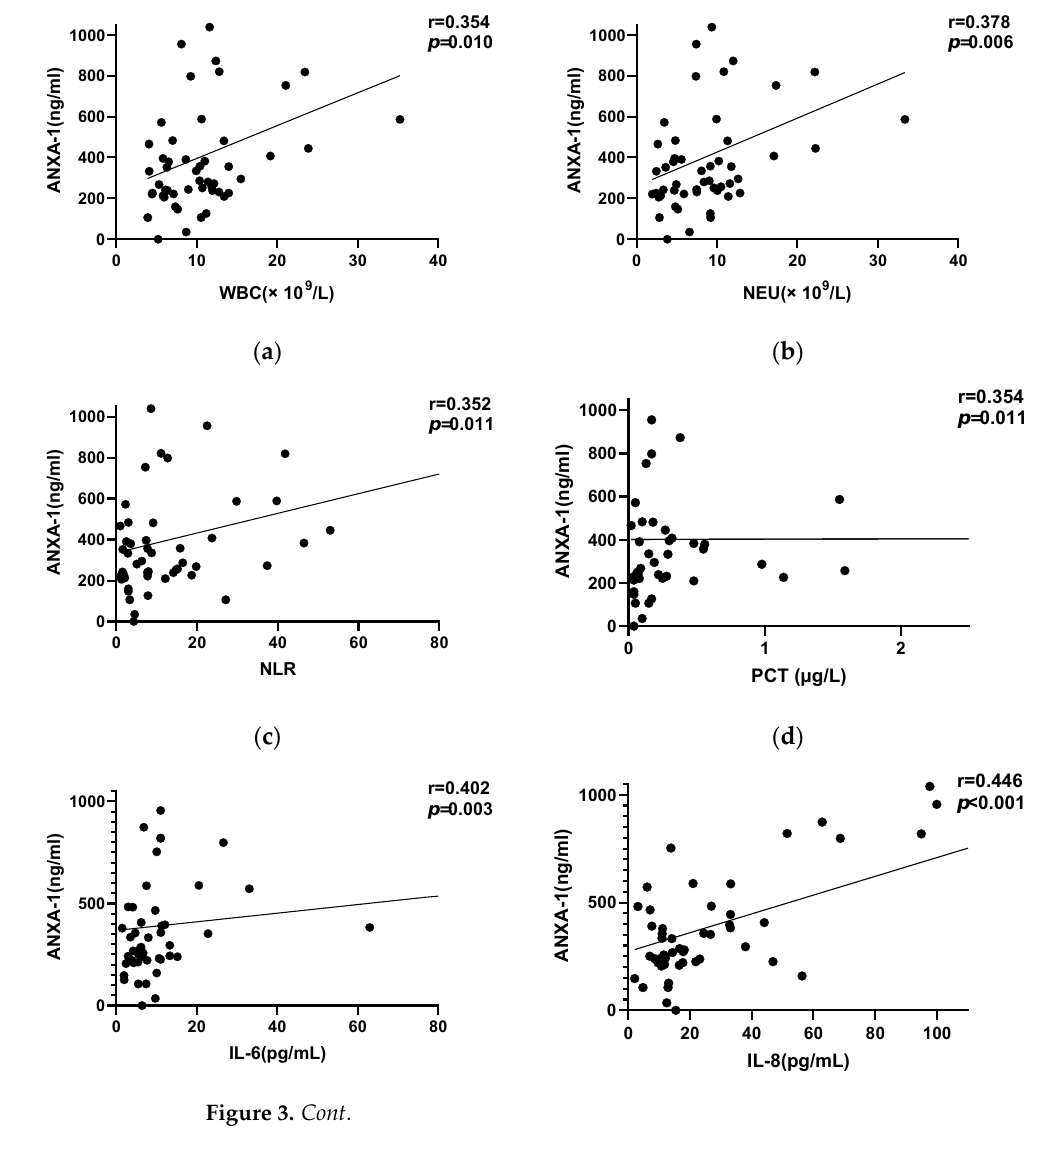
Figure 2. Distribution of AnxA1 by CURB ‐ 65 score and PSI class. ( a ) Statistically significant differ ‐ ences in AnxA1 level were observed among CAP patients according to the CURB ‐ 65 score. ( b ) AnxA1 level distinguished patients with high ‐ risk PSI (classes IV and V). Each point represents the median value.